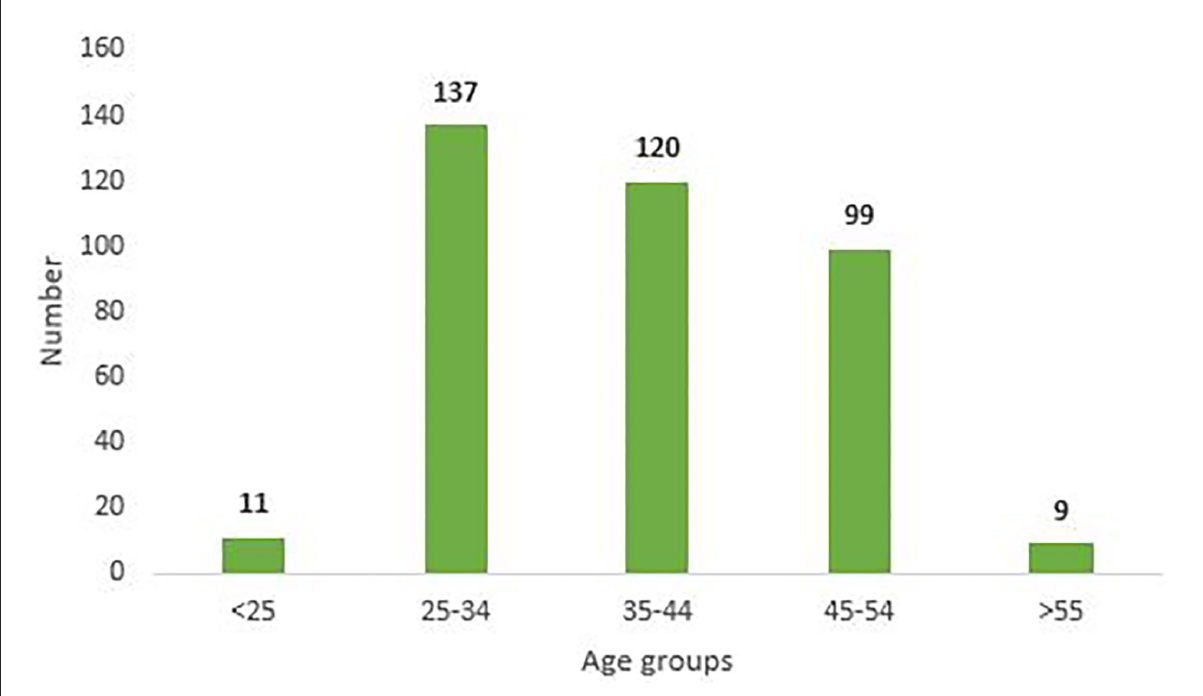
FIGURE1 Age Wise distribution of requests for duty exemption in COVID care areas.